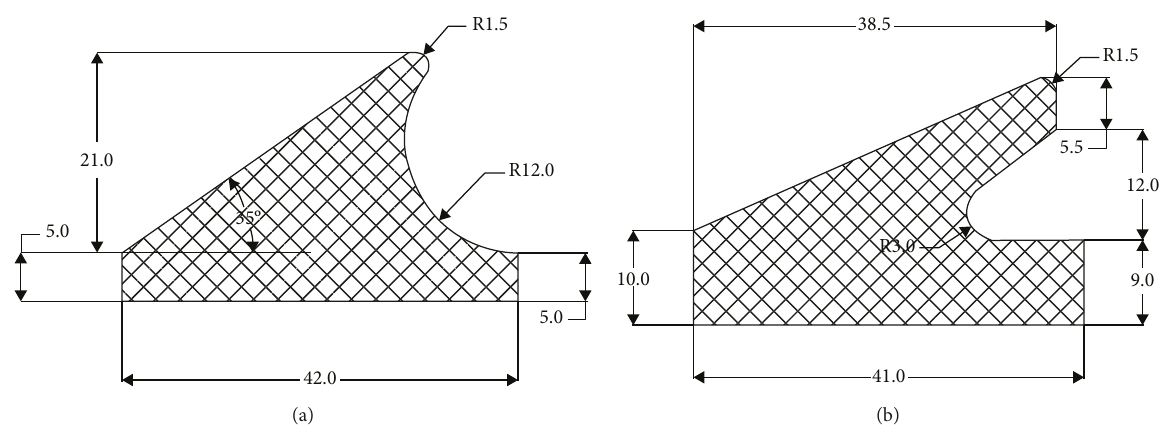
Figure 3: Section size of rubber ring: (a) before optimizing and (b) after